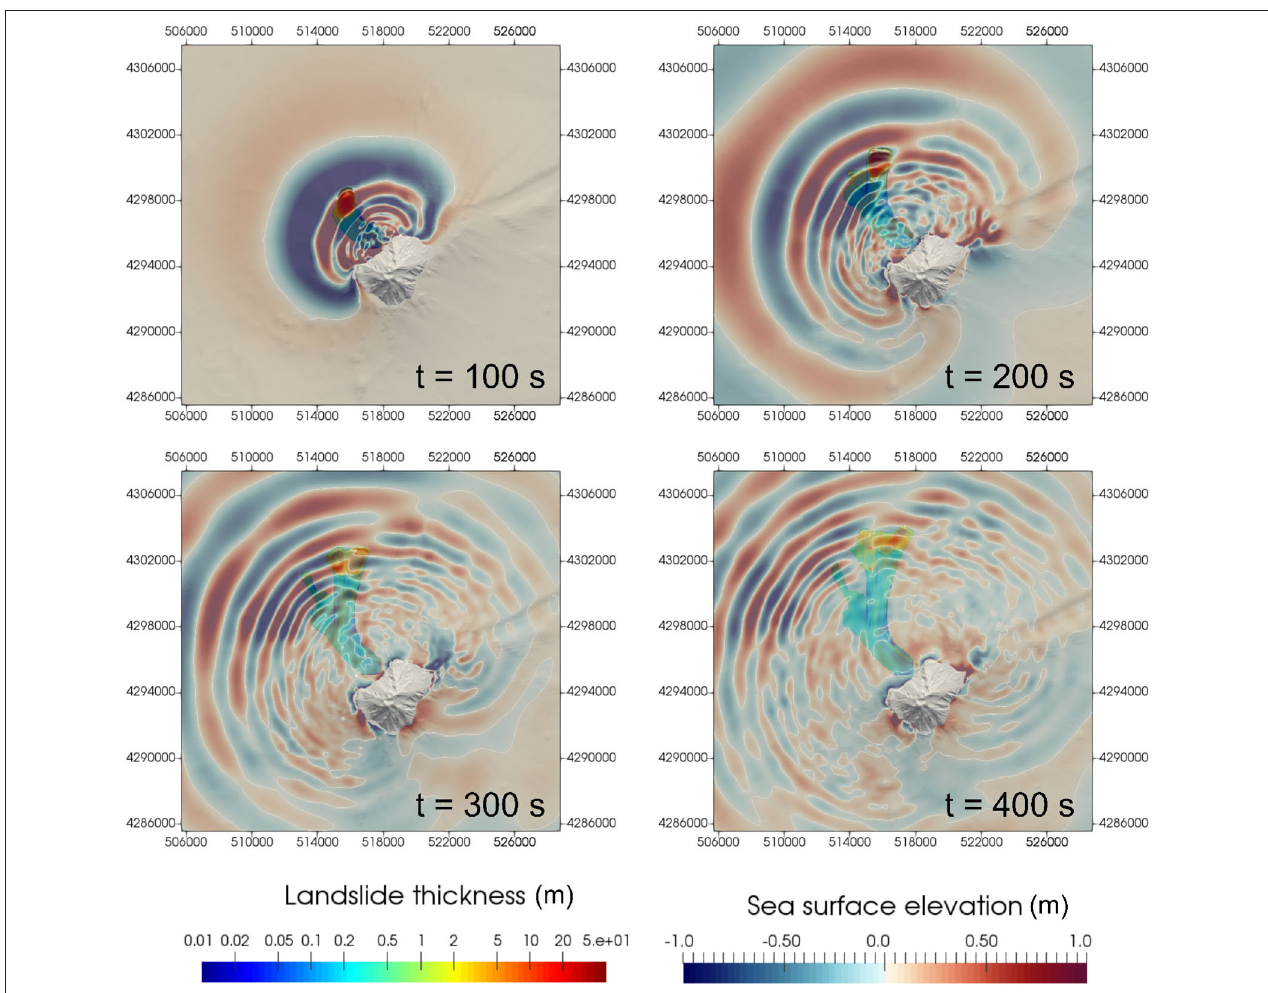
FIGURE 6 | Sea surface elevation and landslide thickness simulated with the Multilayer-HySEA-GL model, with a landslide volume of 17.6 × 10 6 m 3 and three vertical layers. At t = 400 s the landslide has reached its maximum runout and has almost completely